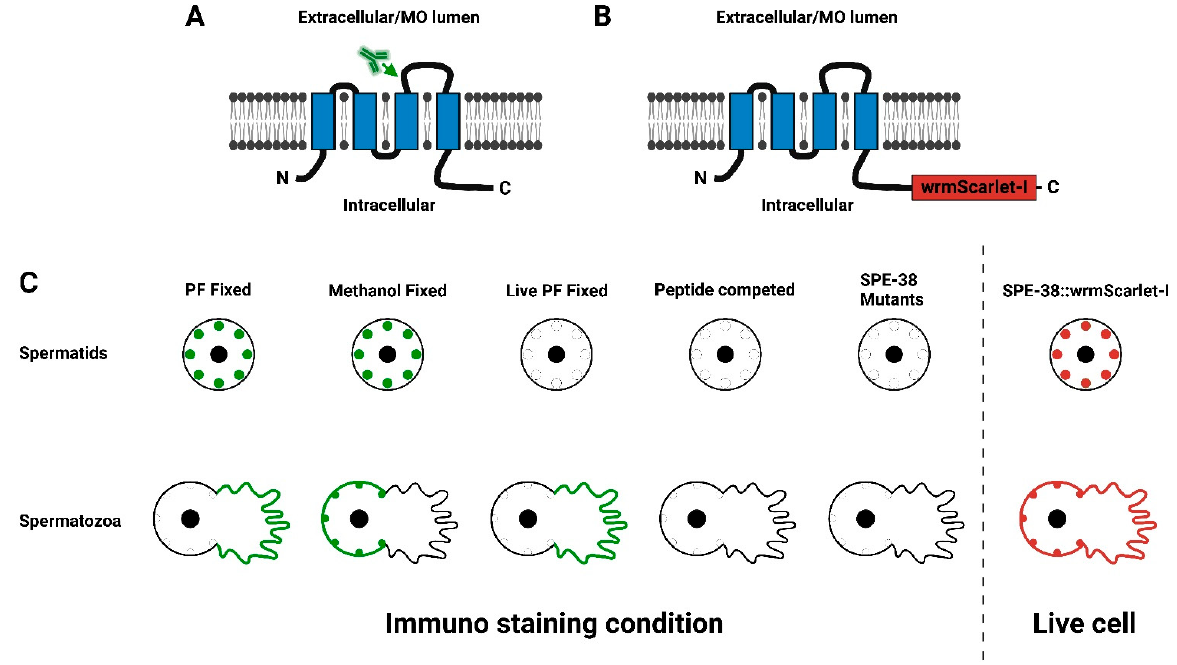
Figure 1. ( A , B ) A schematic representation of the C. elegans SPE-38. The four transmembrane domains are indicated by the blue boxes imbedded in the membrane. The N-Terminus and C-Terminus of SPE-38 are intracellular while the loops between the first and second transmembrane domain and between the third and fourth transmembrane domain are extracellular or in the MO lumen. The antibody symbol and arrow ( A ) indicate the location of the peptide sequence used to raise the polyclonal antisera used by Chatterjee et al., 2005. ( B ) A schematic representation of SPE-38::wrmScarlet-I. The red box (not to scale) indicates the location of wrmScarlet-I. The wrmScarlet-I sequence is codon optimized for expression in C. elegans along with key sequence changes (-I isoleucine substitution) that improve molecule stability. ( C ) The left panel is a schematic summary of previous immunolocalization experiments and controls for antisera specificity published in Chatterjee et al., 2005. Green indicates antibody staining in spermatids and mature sperm. In the right panel red indicates the observed distribution of SPE-38::wrmScarlet-I in spermatids and mature sperm. To determine the subcellular localization of SPE-38, polyclonal rabbit antisera di-